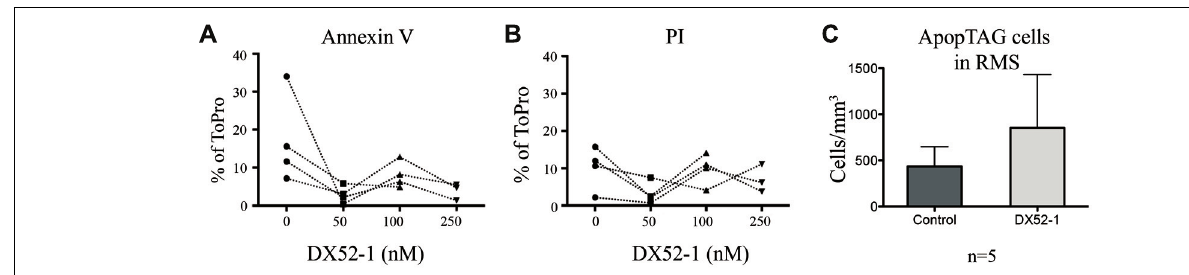
FIGURE 1 | Dose-dependent decrease in migration distance of neuronal progenitor cells from SVZ explants under radixin inhibition. Neural and glial progenitor cells are visualized by PSA-NCAM and Sox2 immunofluorescence. (A) Color separation for PSA-NCAM (top row) and (B) Sox-2 (middle row) expressing cells under increasing concentrations of the radixin inhibitor DX52-1 (Vehicle, 10, 50, 100, and 250 nM). (C) Bottom row depicts color merge of PSA-NCAM (green),